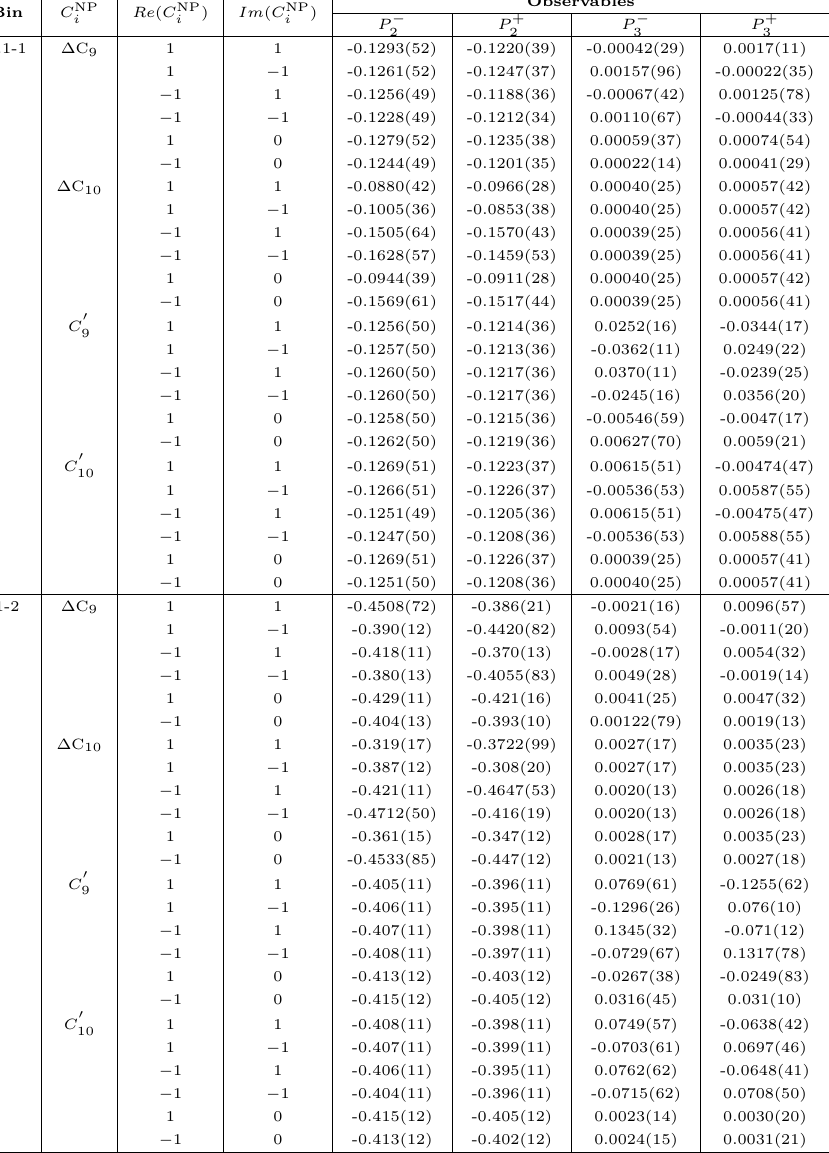
Table 28 . The dependence of some of the optimized observables corresponding to B + → ρ + ll and B − → ρ − ll on the real and imaginary parts of the NP WC’s ∆ C 9 , 10 and C 0 and 1 − 2 GeV 2 for a few benchmark values of the real and imaginary parts of the corresponding